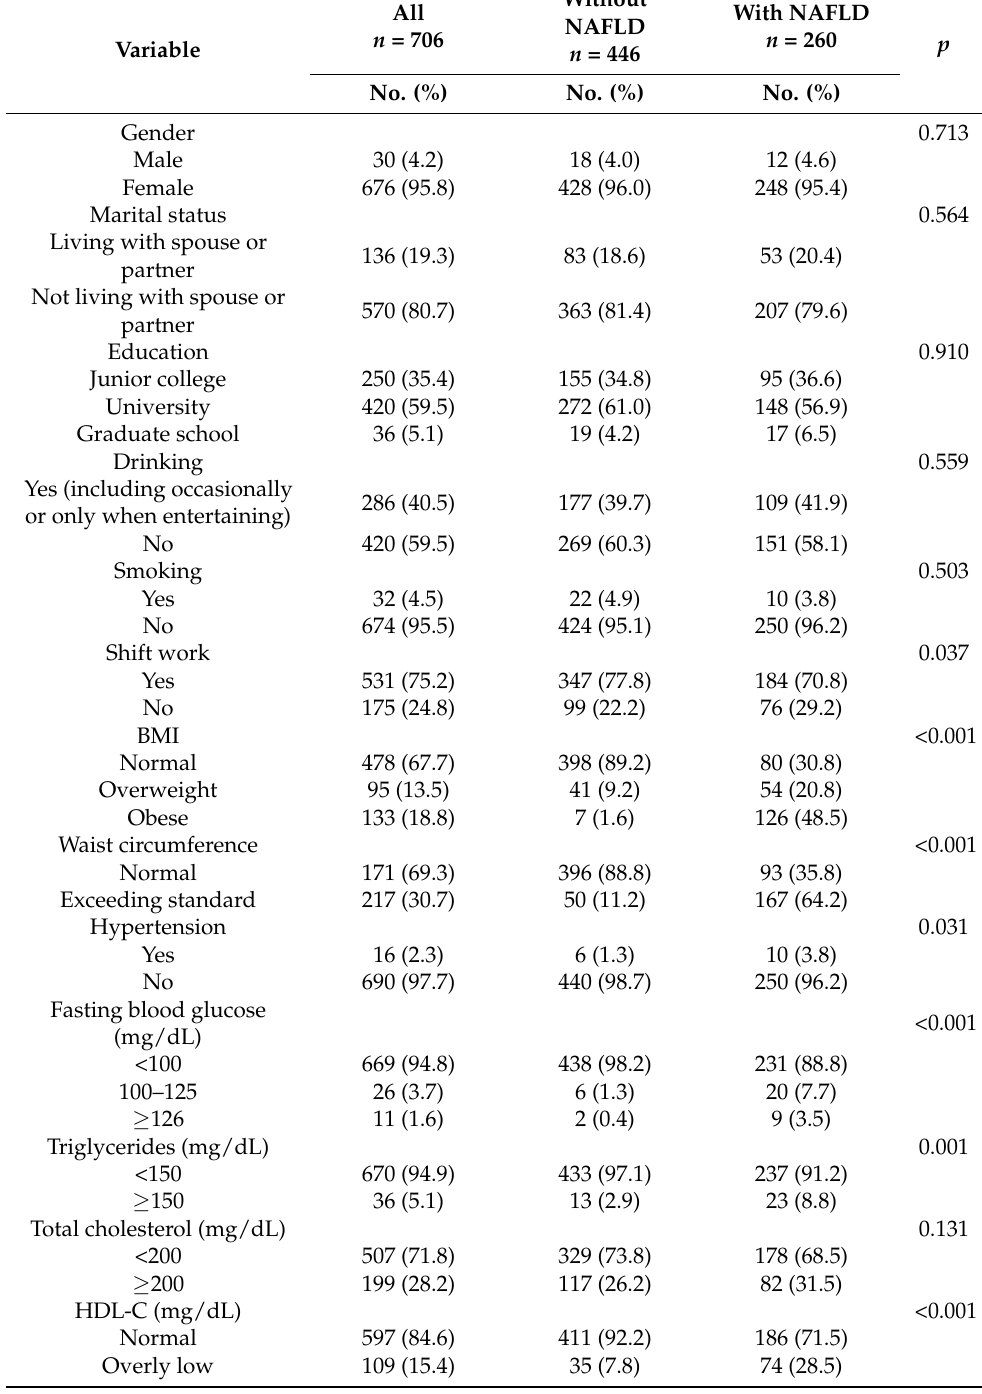
Table 1. Analysis of NAFLD and basic information of